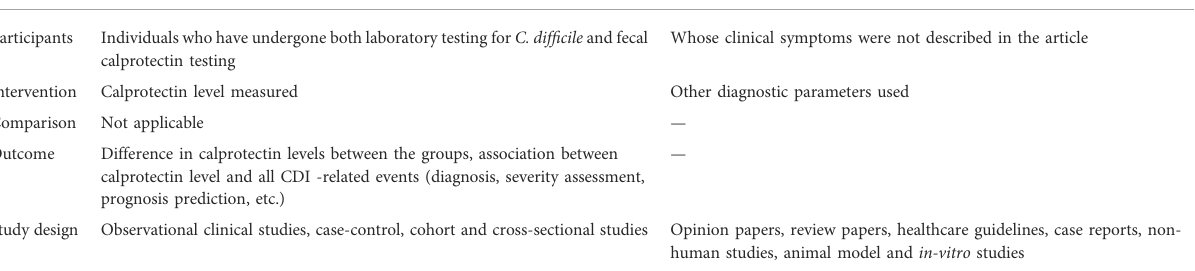
TABLE 1 Eligibility criteria. PICOS